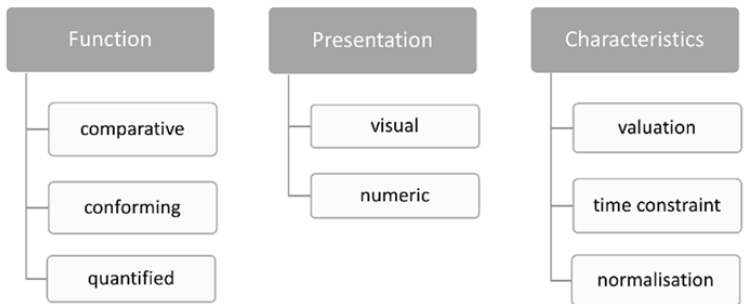
Figure 1. Identification of metric functions, presentation methods, and characteristics.